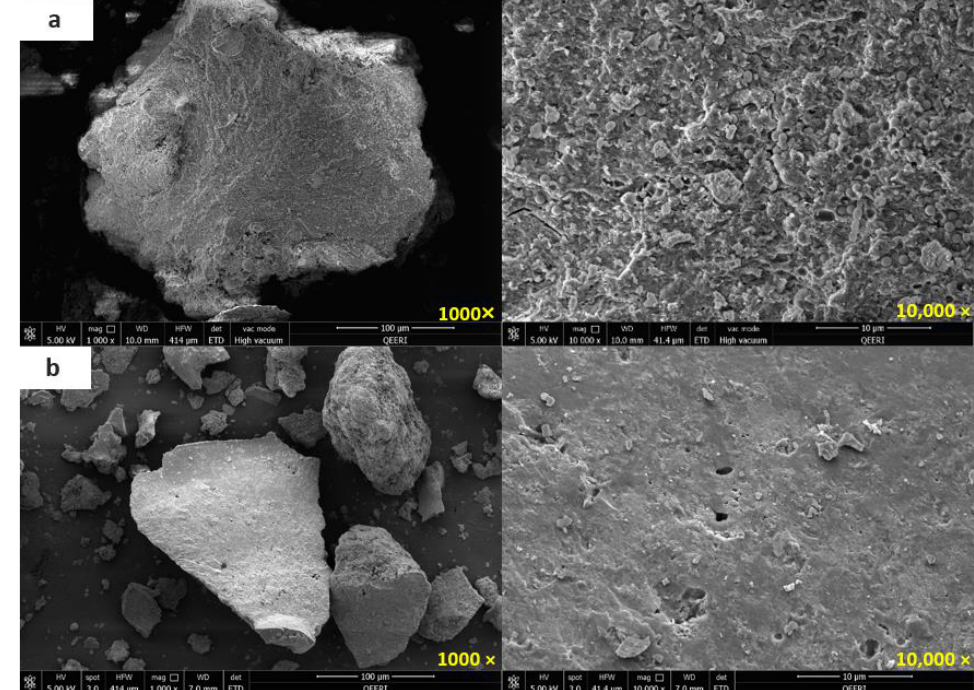
Figure 3. SEM imaging results. ( a ) Biosolid (BS); ( b ) Biosolid char (BSC).